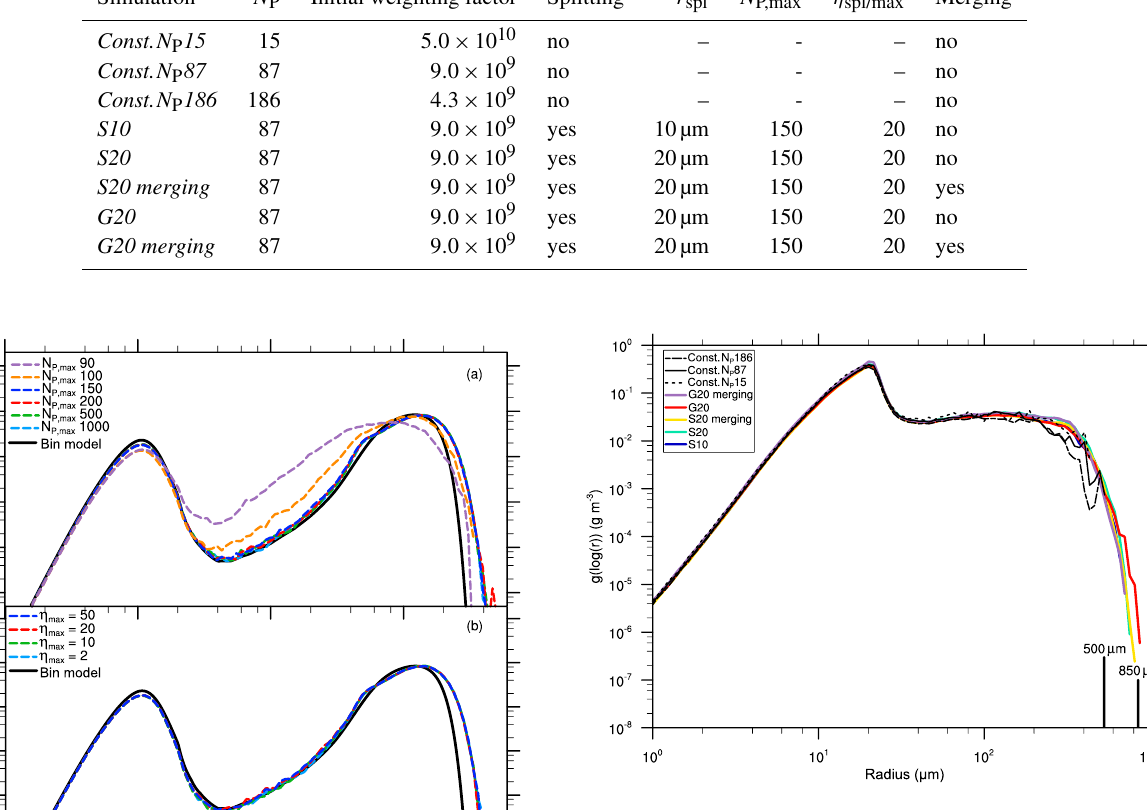
Figure 13. Mass density distribution after 1800s for the idealized single-cloud simulations using parameters described in Table